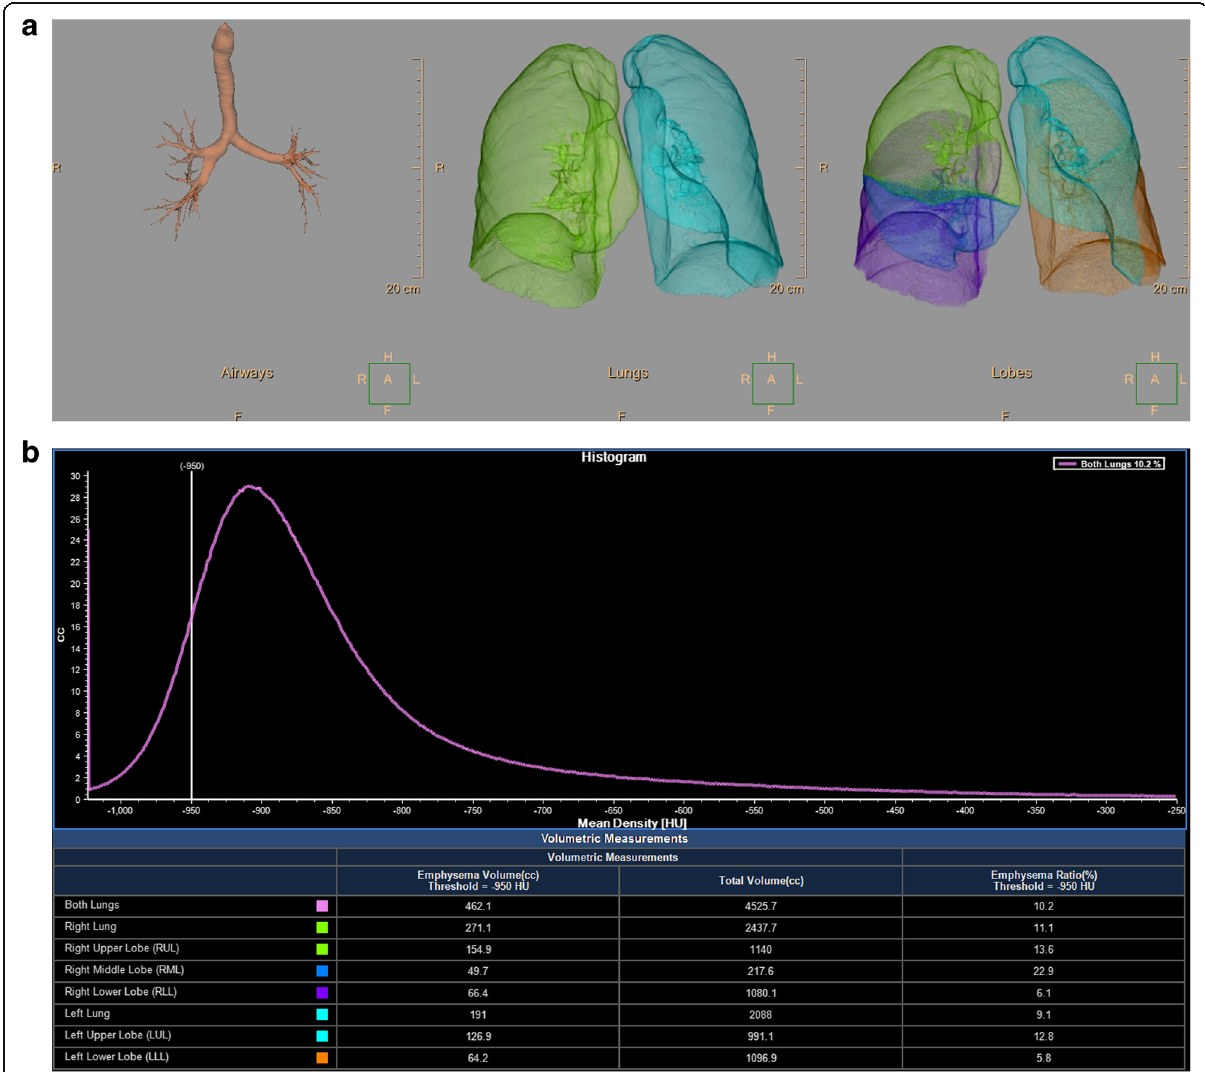
Fig. 1 Example of the semi-automatic software which was used for emphysema quantification. First, the airways, lungs and lung lobes are segmented ( a ). Subsequently, a histogram is made which displays the number of voxels with a certain density ( b ). In this example the percentage of voxels below -950 HU is